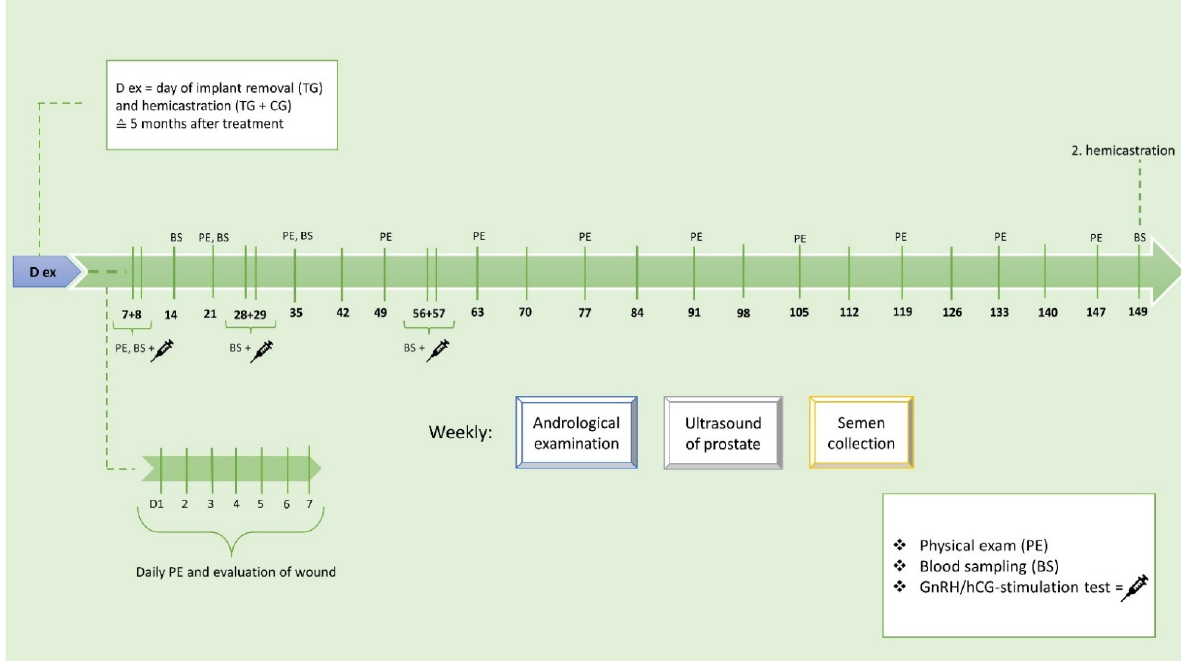
Figure 1. Detailed experimental design. The study includes two groups: TG animals ( n = 7) were treated with a 4.7 mg deslorelin slow-release implant (SRI) in the paraumbilical area, whereas CG animals ( n = 3) were subcutaneously treated with 0.5 mL saline in the umbilical area. In one TG animal (Lui), the induced effects were already fully reversed, which is why he was excluded from further analysis here.